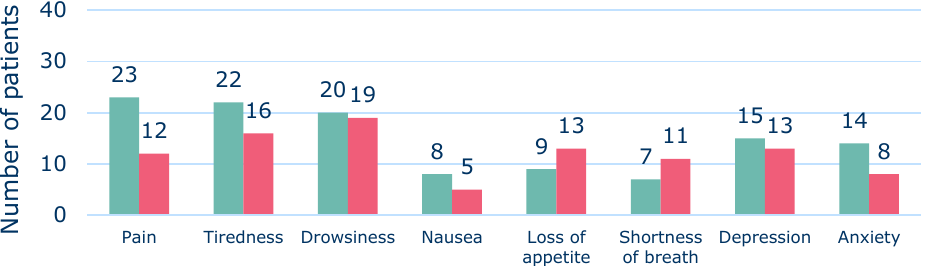
Figure 3. Number of Deprescribing Subgroup patients ( n = 48) with improvements (green) and deteriorations (red), respectively, in each symptom after deprescribing.